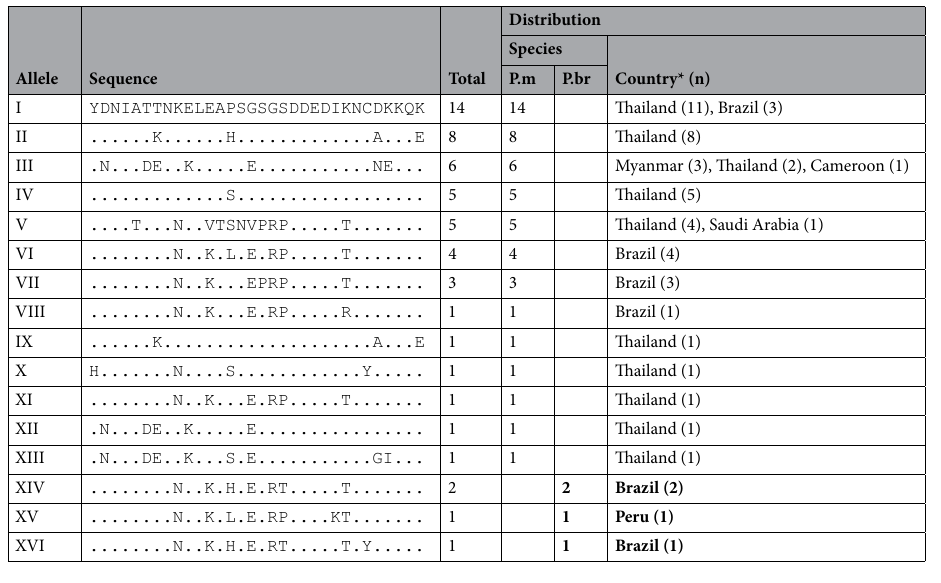
Table 2. Distribution of alleles in block IV of PmMSP1 and PbrMSP1 . P.m and P.br denote Plasmodium malariae and P. brasilianum , respectively. Dots represent corresponding identical amino acids per allele I. Thai isolates and GenBank accession numbers of isolates elsewhere are (I) PM3-PM8, PM16-PM19, PM33, KR072273, KR072274 and KR072276; (II) PM13 and PM20-PM26; (III) PM1, PM27, KX672046–KX672048 and FJ824669; (IV) PM11, PM12 and PM28–PM30; (V) PM14, PM31, PM32, PM34 and FLQW01000468; (VI) KR072269, KR072272, KR072278 and KR072279; (VII) KR072271, KR072275 and KR072277; (VIII) KR072270; (IX) PM9; (X) PM10; (XI) PM15; (XII) PM2; (XIII) PM35; (XIV) KR072281 and KR072283; (XV) KR072284 and (XVI) KR072282. *Bolds are countries for P.